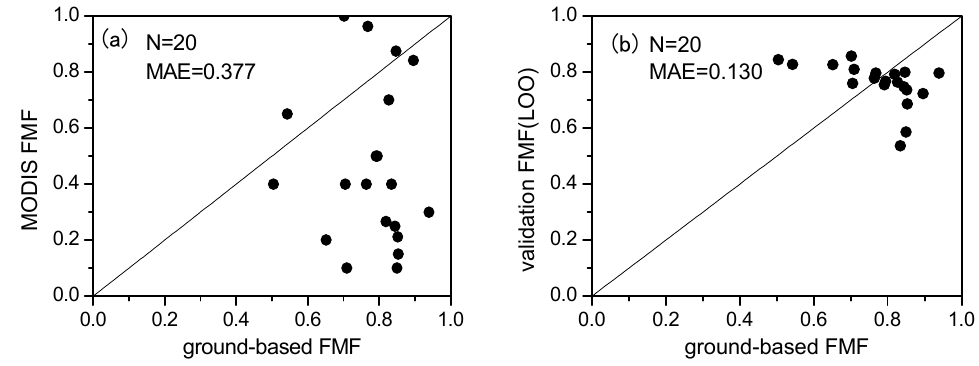
Figure 5. ( a ) Matching data pairs for MODIS FMF and ground-based FMF ( N = 20); and ( b ) leave-one-out cross-validation results ( N = 20).